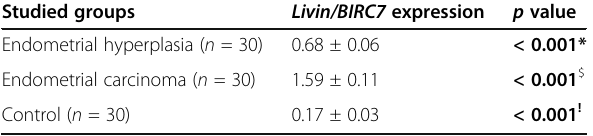
Table 2 Livin/BIRC7 expression level in the studied groups Studied